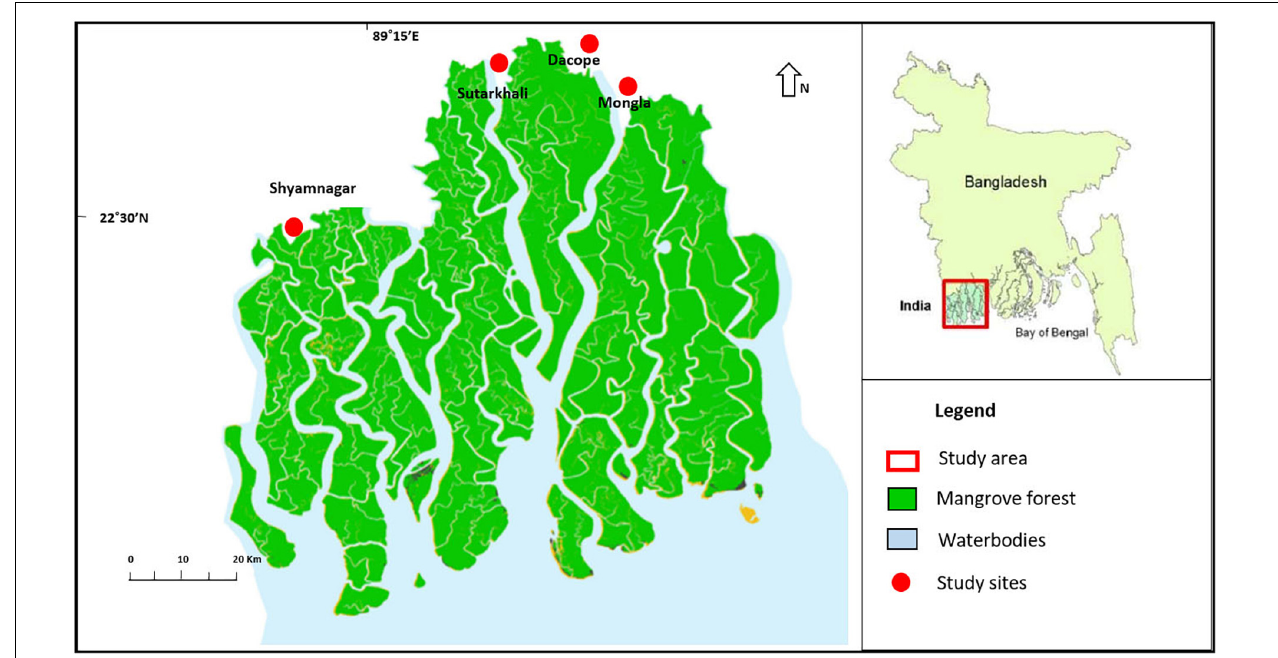
FIGURE 1 | Bay of Bengal and CREL research sites (red